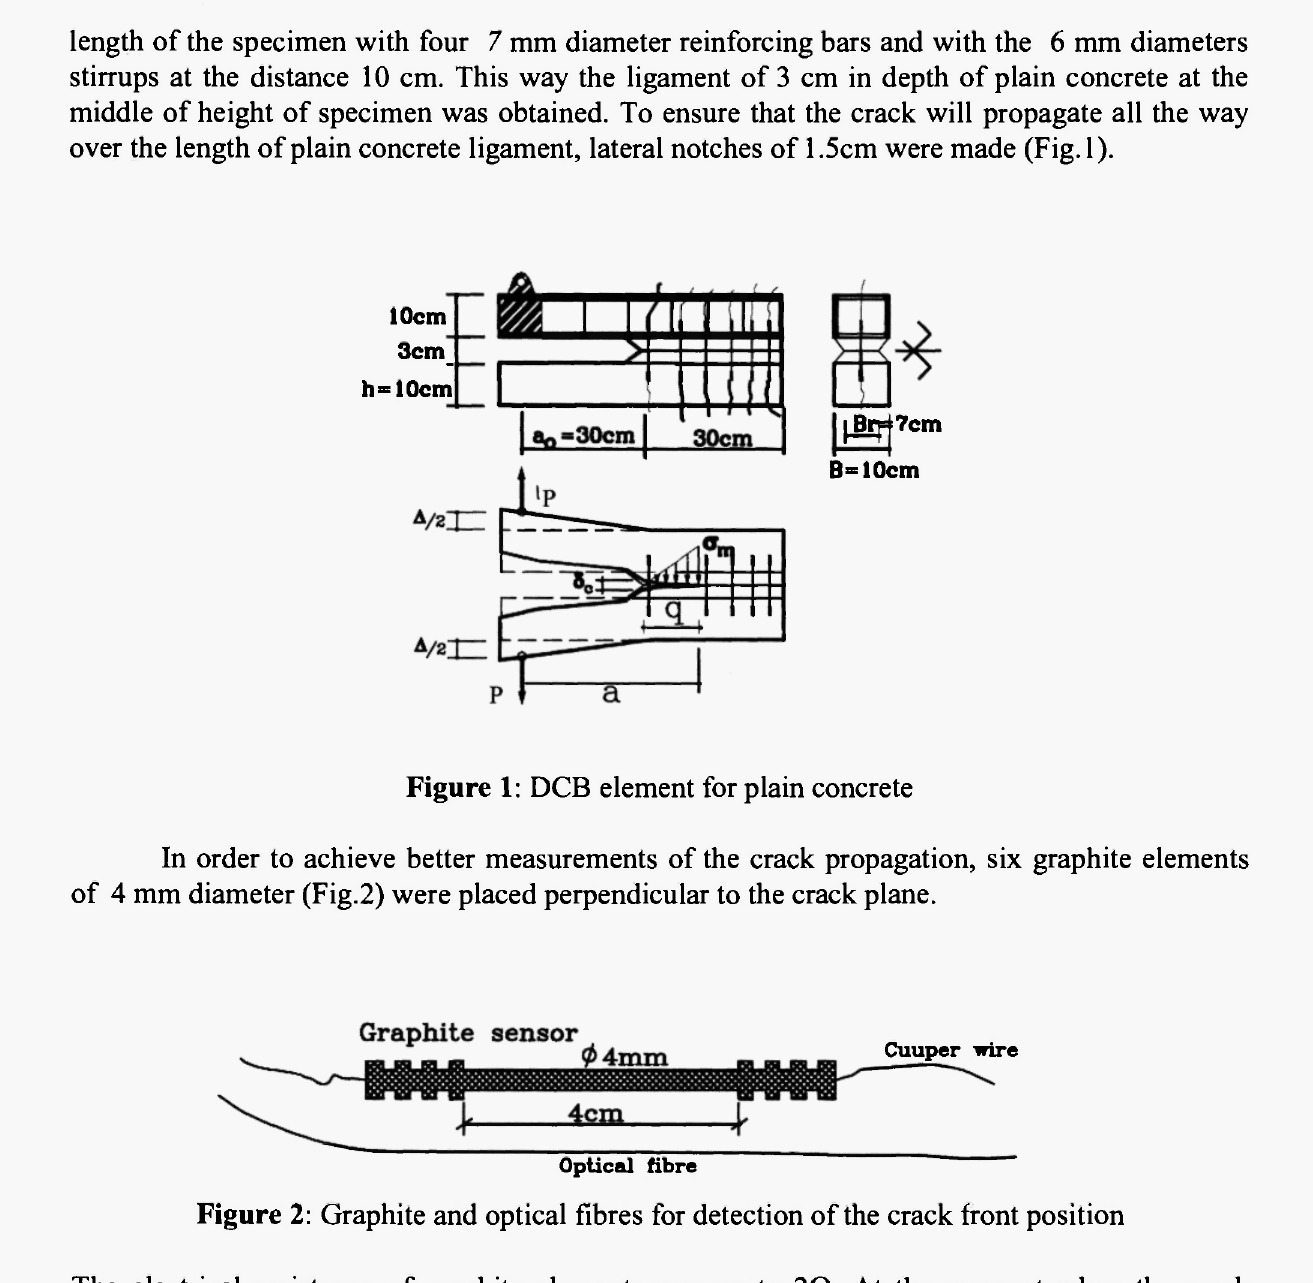
Figure 2: Graphite and optical fibres for detection of the crack front